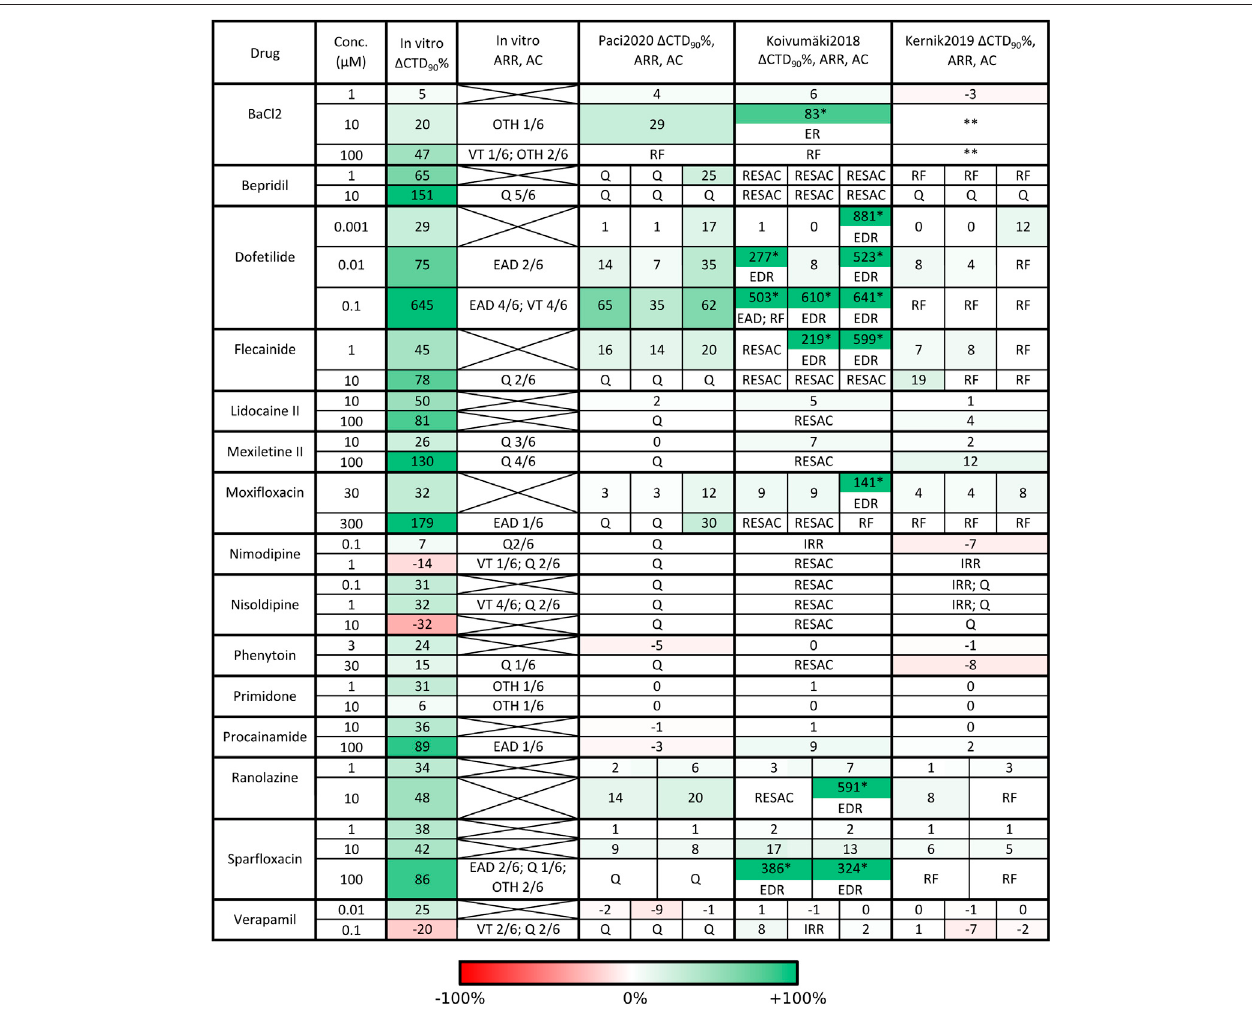
FIGURE7| Qualitativeandquantitativecomparisonof insilico drugtestsinthethreehSC-CMmodelsagainstour invitro data,forthe15referencecompounds.For each drug we report i) the tested concentrations, ii) the percent CaT duration variation with respect to baseline ( Δ CTD 90 %), arrhythmic events (ARR) and automaticity cessation (AC) recorded in vitro and in silico . Arrhythmic events: early and delayed after-depolarization (EAD, DAD), repolarization failure (RF), irregular rhythm (IRR), ventricular tachycardia-like rhythm (VT) and other arrhythmic events (OTH). Automaticity cessation (AC): quiescence (Q) and residual activity (RESAC). Q and RESAC are not considered pro-arrhythmic. ForKoivumäki2018, the Δ CTD 90 % marked with a star were computed on EADsand the model showed arrhythmic patterns including the combination of EADs, DADs and RF (shortened as EDR) or EADs and RF (shortened as ER). For Kernik2019, two stars in BaCl 2 mean high rate Ca2 + oscillations and depolarized maximum diastolic potential, but no RF. When multiple combinations of IC 50 and Hill coef fi cient were tested in simulation for the same compound, the corresponding in silico results consist of multiple sub-columns. In case of no in vitro arrhythmic events, the corresponding cell contains an X. An expanded version of this table is presented in the Supplementary material as Supplementary Table S2